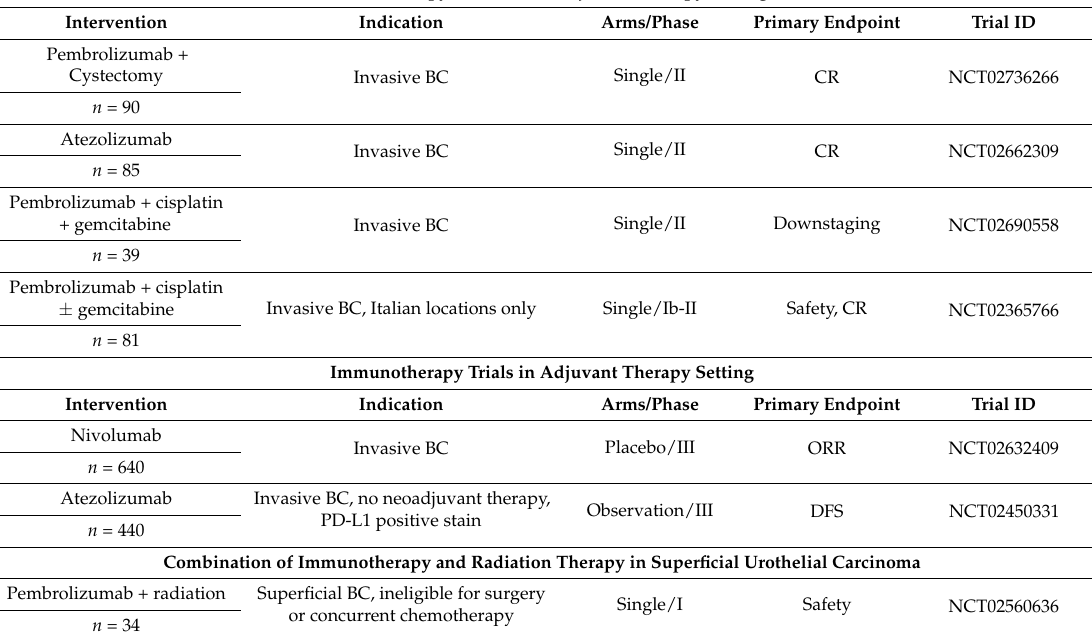
Table 3. Ongoing immunotherapy trials in neoadjuvant and adjuvant settings and with radiation in bladder